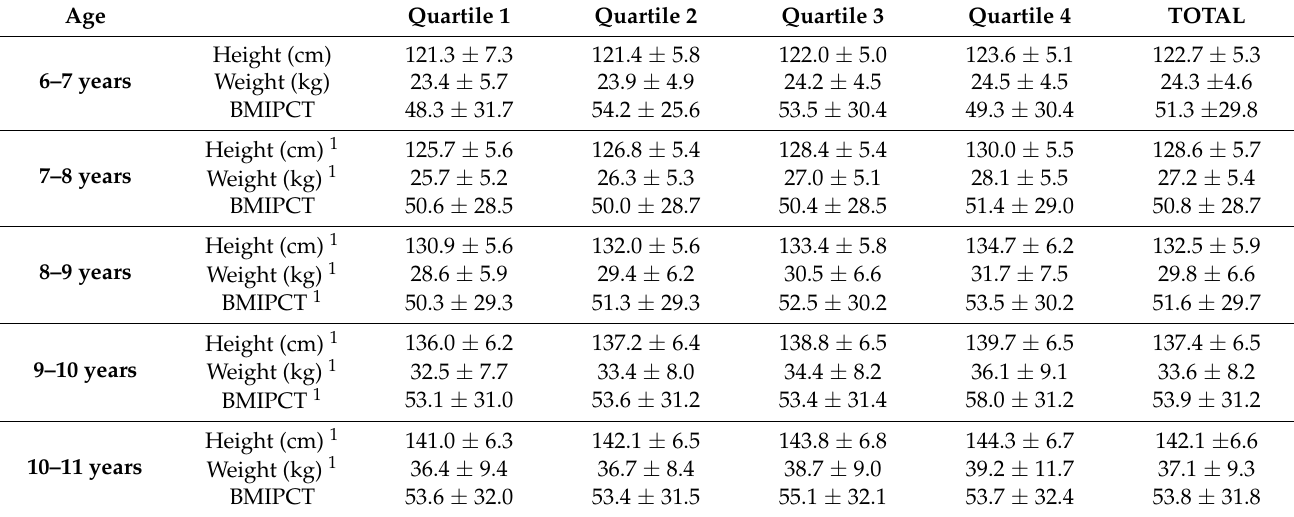
Table 2. Anthropometric characteristics by age group and age-specific